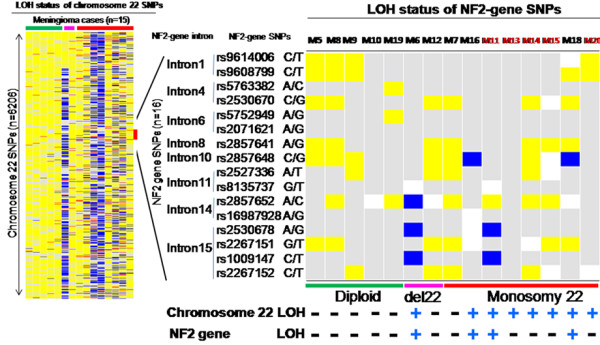
LOH profiles of chromosome 22 and the NF2 gene in sporadic meningiomas (n = 15). Rows (n = 6206) correspond to individual SNPs along the entire chromosome 22 and columns identify different meningiomas. Blue indicates presence of LOH, allele retention is shown in yellow, while red indicates conflict between PB DNA and tumor DNA SNP calls (AA or BB in PB and AB or BB and AB or AA in the tumor sample, respectively), and absence of call for non-informative SNPs (AA or BB) are depicted in white and grey, respectively. Two tumors (M7 and M12) showed a pattern compatible with biclonal allele deletions with copy number value of 1 in the absence of LOH. The NF2 gene locus containing 16 SNPs in the array is amplified in the right side of the figure to better show the status of those SNPs heterozygously distributed in introns 1, 4, 6, 8, 10, 11, 14 and 15. LOH for three NF2-associated SNPs was found in one tumor (M6), for two SNPs in another case (M11) and for one SNP in another two meningiomas (M16 and M18).